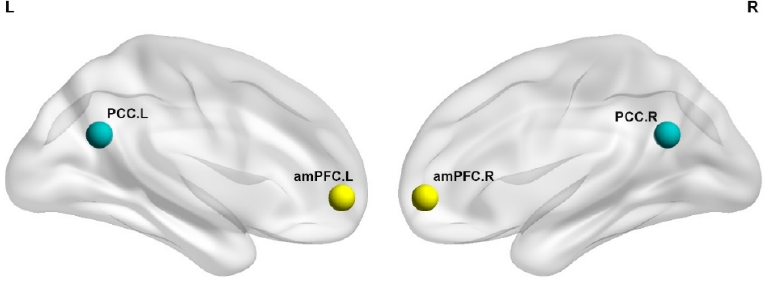
Figure 1. Schematic of ROIs in DMN core regions used in the current study. amPFC = anteromedial prefrontal cortex; PCC = posterior cingulate cortex; L = left; R = right.